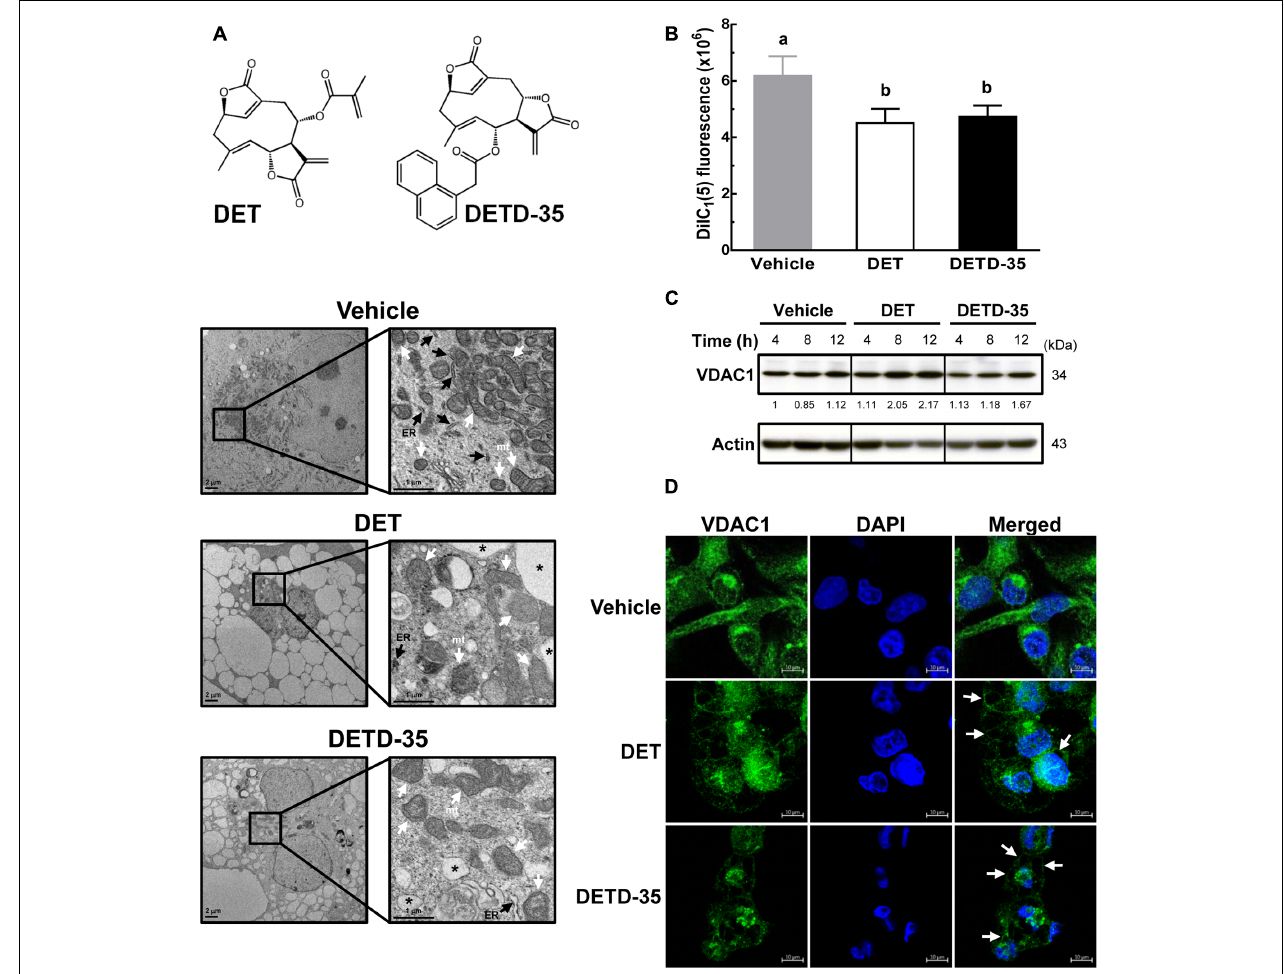
FIGURE 1 | Deoxyelephantopin (DET) and DET derivative (DETD)-35 induced morphological change and challenged structural integrity of mitochondria in MDA-MB-231 cells. (A) MDA-MB-231 cells were treated with vehicle (0.5% DMSO) or IC 50 concentrations for inhibiting MDA-MB-231 cells of DET (11 µ M) and DETD-35 (3 µ M) for 24 h, and the morphological changes of cancer cells were examined by transmission electron microscopy (TEM) imaging (10,000 × magnification). The ER, mitochondria (mt), and cytoplasmic vacuoles are indicated by black arrowheads, white arrowheads, and asterisks, respectively. (B) MDA-MB-231 cells were treated with vehicle (0.5% DMSO), 11 µ M DET, and 3 µ M DETD-35 for 2 h. The vehicle– and compound–treated cells were labeled with DiIC 1 (5) (10 µ M) fluorescence dye for 30 min, and mitochondrial membrane potential of the treated cells was determined using flow cytometry. Data are mean ± SEM, n = 3. Different letters indicate significant differences (one-way ANOVA, P < 0.05). (C) Western blotting of VDAC1 protein in MDA-MB-231 cells treated with vehicle (0.5% DMSO), 11 µ M DET, or 3 µ M DETD-35 for 4, 8, and 12 h. Quantification of the corresponding protein bands was performed using ImageJ software. β -actin was used as a loading control. (D) Immunofluorescence analysis of MDA-MB-231 cells treated with vehicle (0.5% DMSO), DET (11 µ M), or DETD-35 (3 µ M) for 24 h. The treated cells were fixed using 100% ice-cold methanol, and stained with VDAC1 (green), and DAPI (blue) to visualize mitochondrial structures and nuclei. White arrowheads indicate DET– and DETD-35–induced cytoplasmic